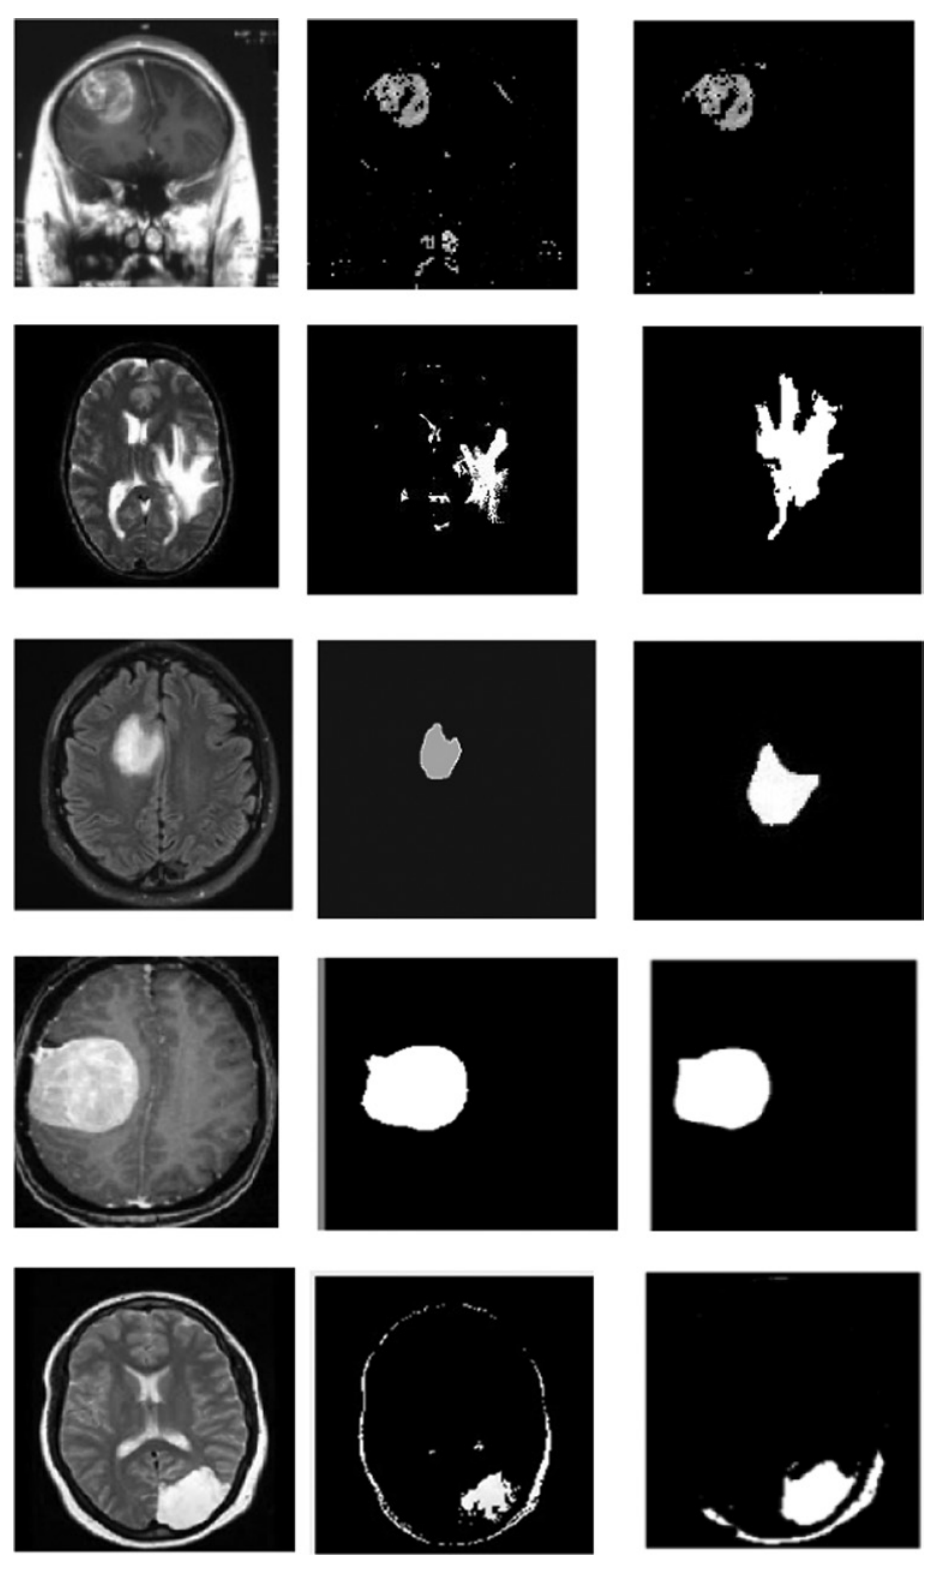
Figure 8: MRI Brain Tumour Medical Images for Comparison. First column: original image for tumours 01–05. Second column: tumour extracted by reported segmentation methods proposed in Refs. [27], [2], [15], [3], and [5], respectively. Third column: tumour extraction by the proposed